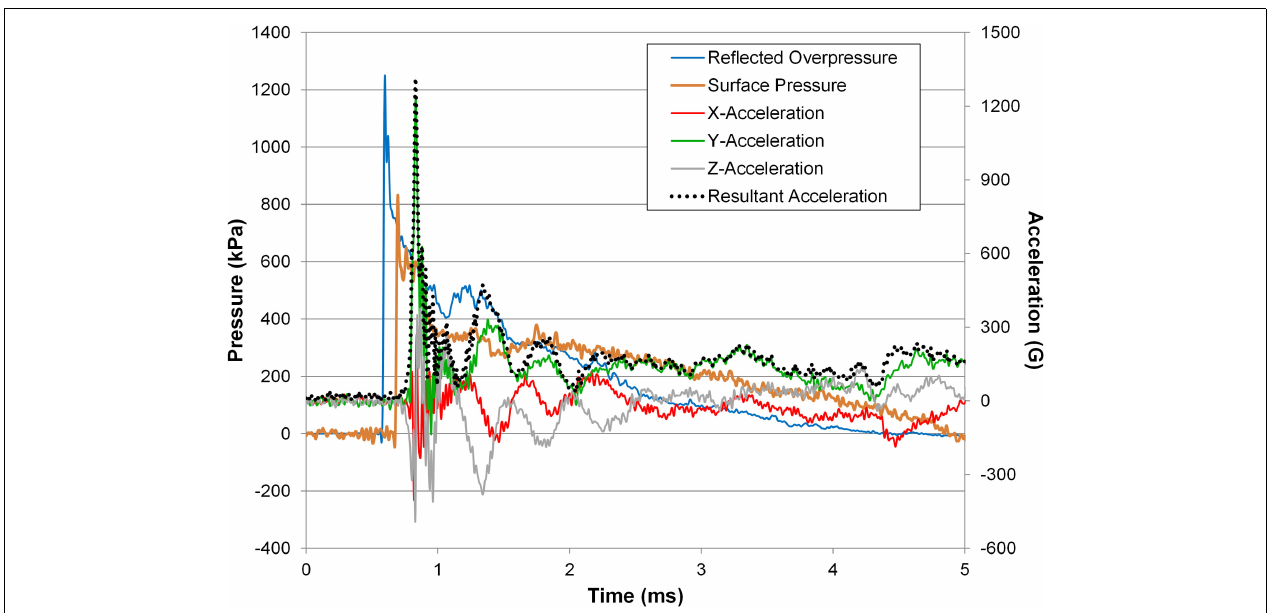
FIGURE 9 | Head acceleration response for a 242-kPa average peak overpressure and 3.52ms positive phase duration shock wave.